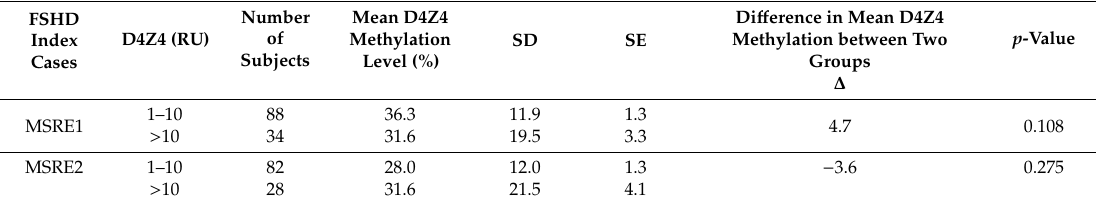
Table 1. Mean D4Z4 methylation level and di ff erence ( ∆ ) in mean D4Z4 methylation between two groups reported in Figure